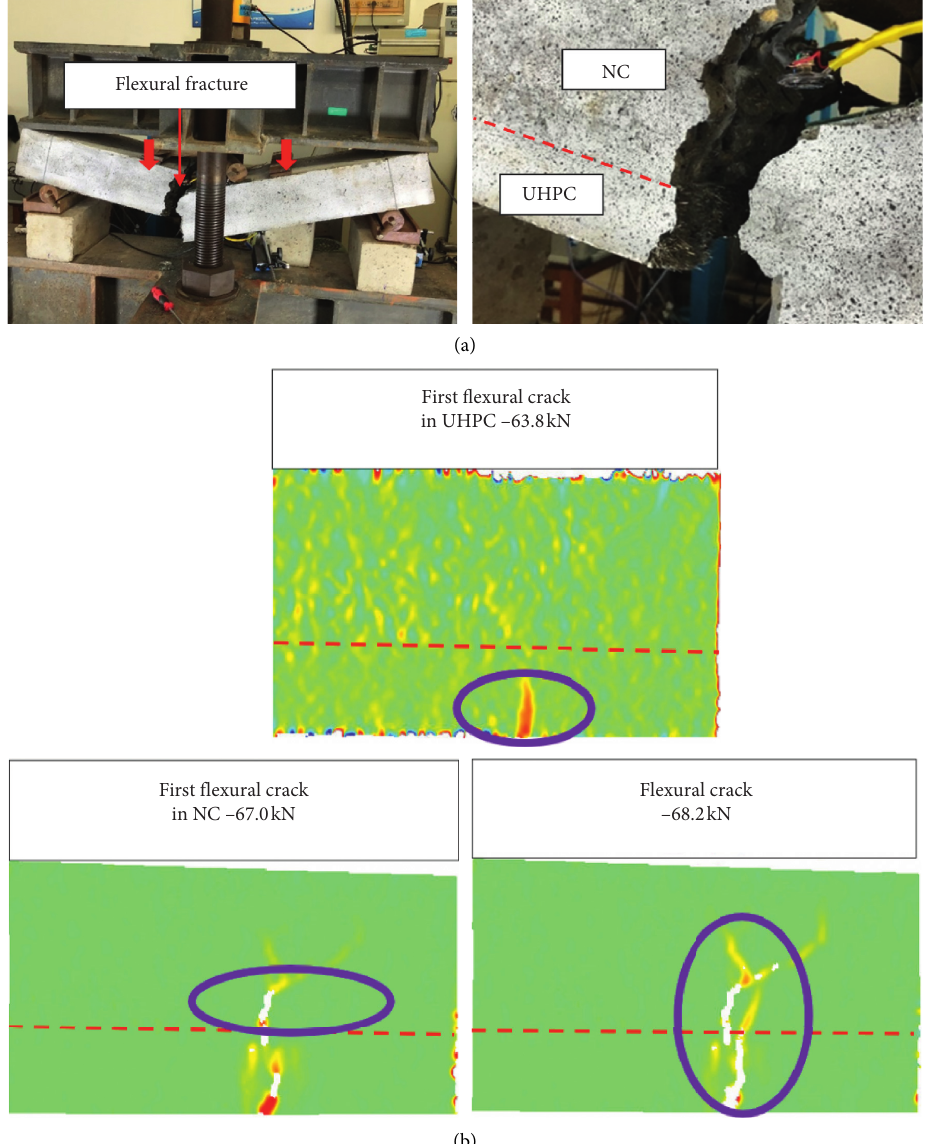
Figure 11: Failure patterns and damage evolutions of specimen U50. (a) Photos for failure pattern. (b) Damage tracking with DIC